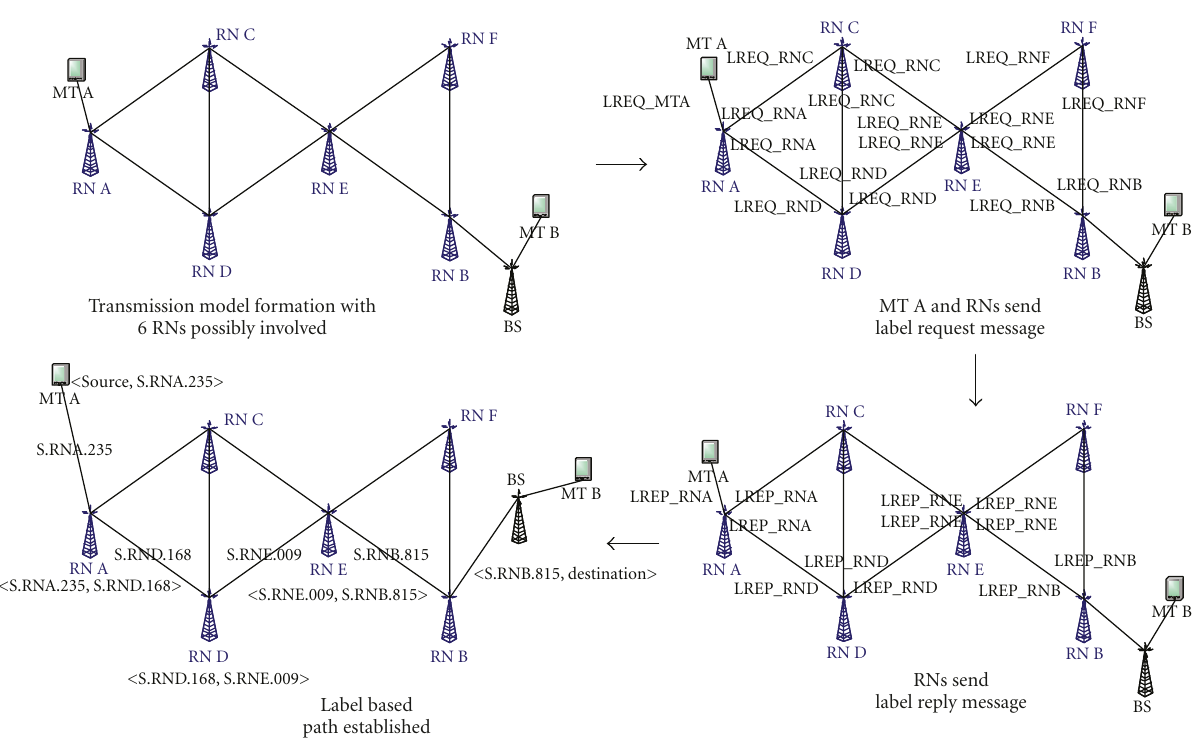
Figure 6: Label routing